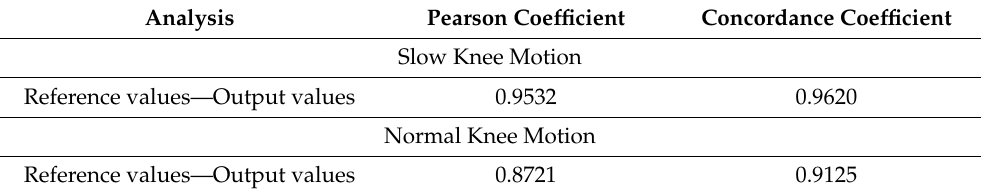
Table 2. Analysis of slow and normal knee